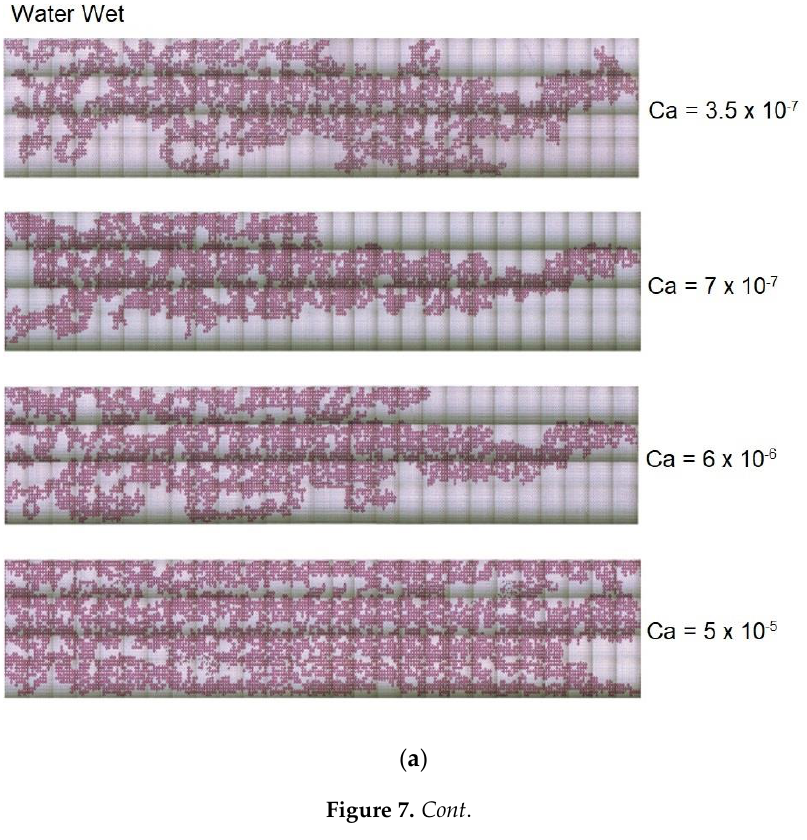
Figure 6. Water invasion pattern in two different hydrophilic porous media microfluidic devices manufactured from the same mask. Ca = 3.5 × 10 − 7